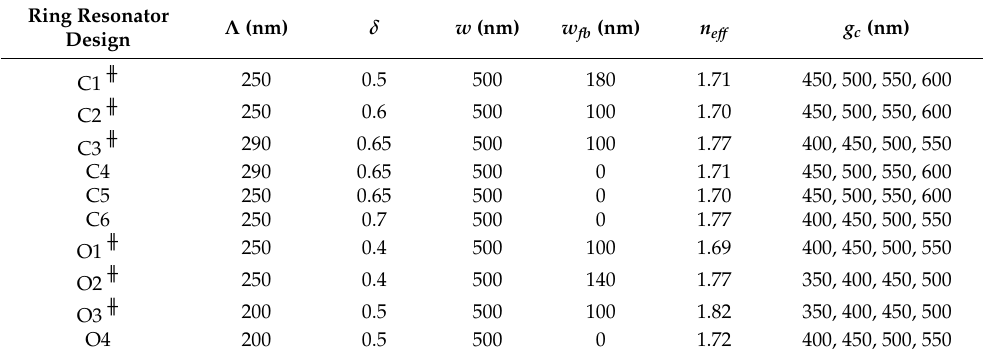
Table 2. Group index, n g , and free spectral range ( FSR ) for SWG ring resonators obtained from 3D-FDTD band structure simulations with water cladding. All waveguides have a thickness of 220 nm.